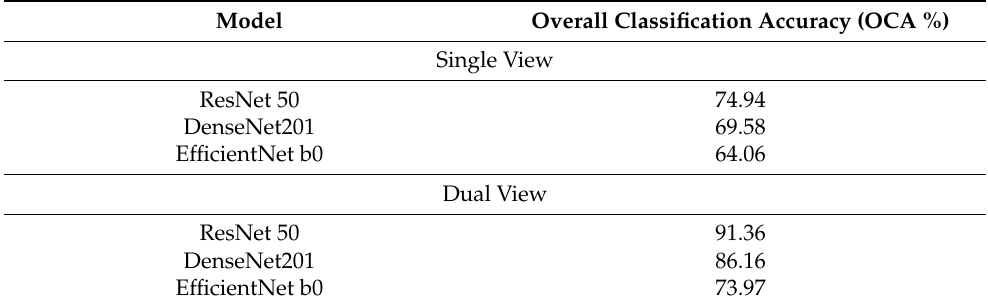
Figure 5. A comparison of the visual effects of different image preprocessing tasks. Table 5. The effect of overall classification accuracy of the single view vs. dual View of the DDSM